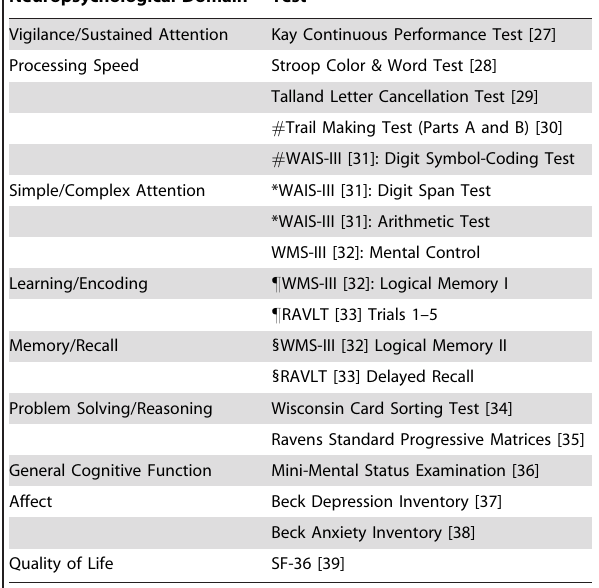
Neuropsychological Domain